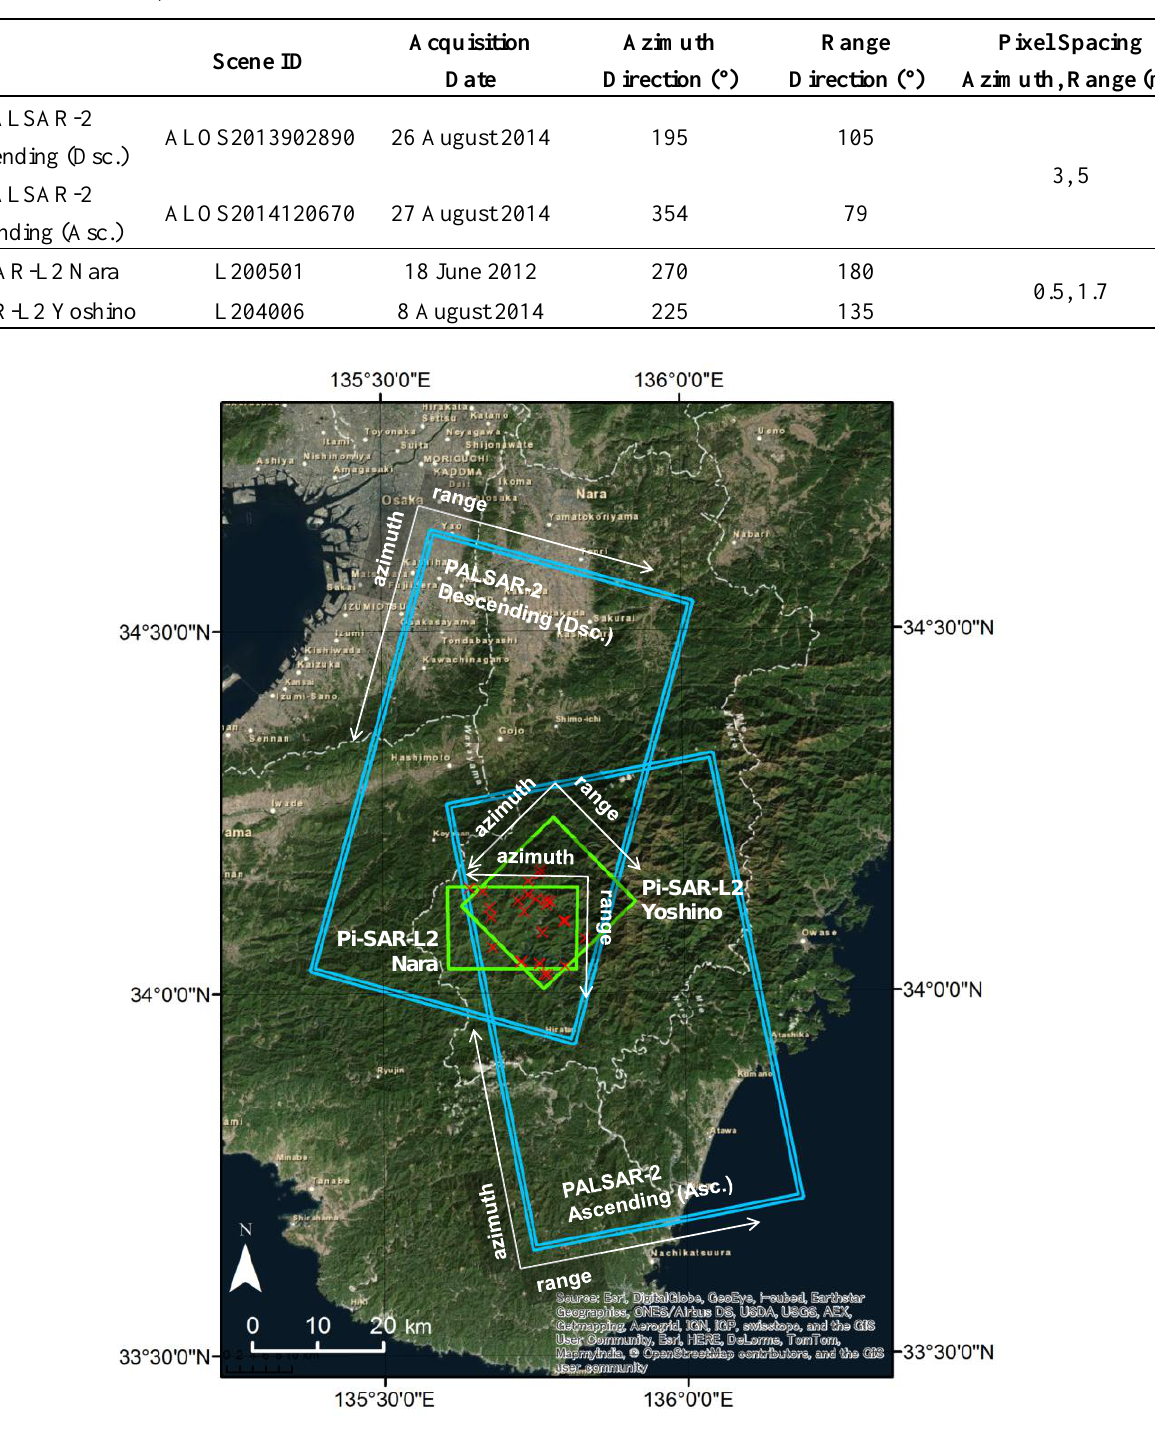
Figure 5. Red crosses indicate deep-seated landslides, which were triggered by torrential rain caused by Typhoon Talas in September 2011 in the study area. Blue and green rectangles show the coverage of PALSAR and Pi-SAR-L2 images, respectively. The flight (azimuth) and the illumination (range) direction for each PolSAR observation are indicated by arrows with